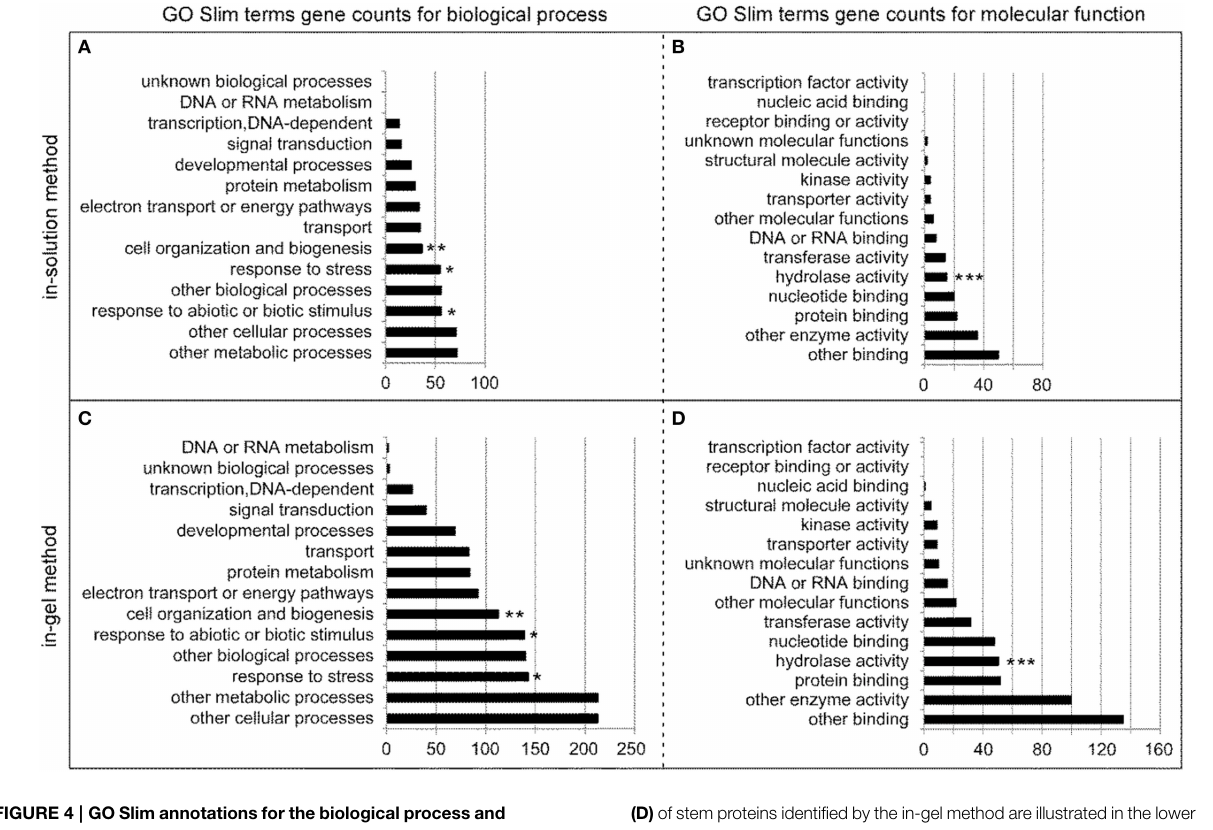
FIGURE 4 | GO Slim annotations for the biological process and molecular function of the 75 and 236 relatively abundant stem proteins identified by in-solution and in-gel methods, respectively. Annotation gene counts for the biological process (A) and molecular function (B) of stem proteins identified by the in-solution method are illustrated in the upper two panels, whereas those for the biological process (C) and molecular function